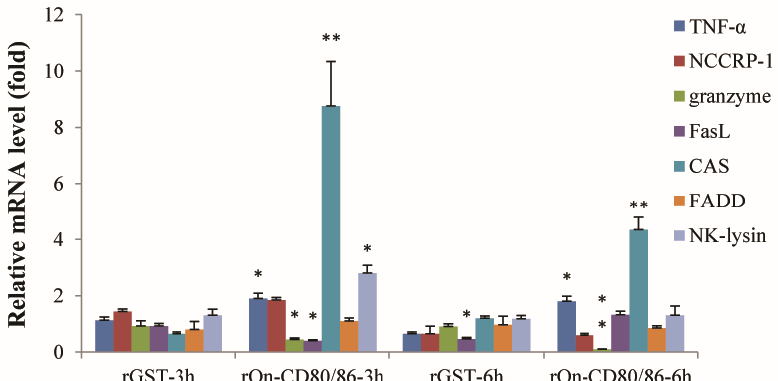
Figure 2. Expression of NCC-related genes after rOn-CD80/86 stimulation by qRT-PCR. All values are the mean ± SD, n = 3. Significant difference was indicated by asterisks, *: 0.05 > p > 0.01, **: p < 0.01.